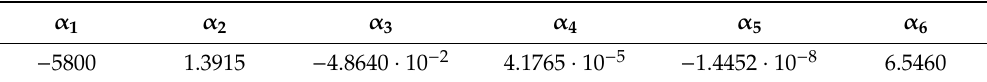
Table 2. Coe ffi cients α i , i = 1 ... 6 of Equation (20) used for the calculation of pure water vapor pressure (Reproduced with permission from [20]. Elsevier,